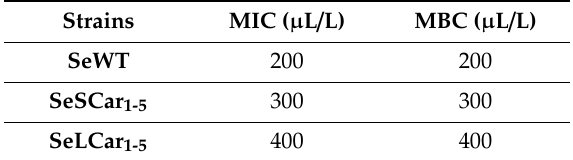
Table 1. Minimum inhibitory concentration (MIC) and minimum bactericidal concentration (MBC) of carvacrol for Salmonella enterica subsp. enterica serovar Typhimurium LT2 wild type (SeWT) and evolved strains: SeSCar 1-5 (5 strains selected by cyclic exposure to prolonged sublethal treatments of carvacrol) and SeLCar 1-5 (5 strains selected by cyclic exposure to short lethal treatments of